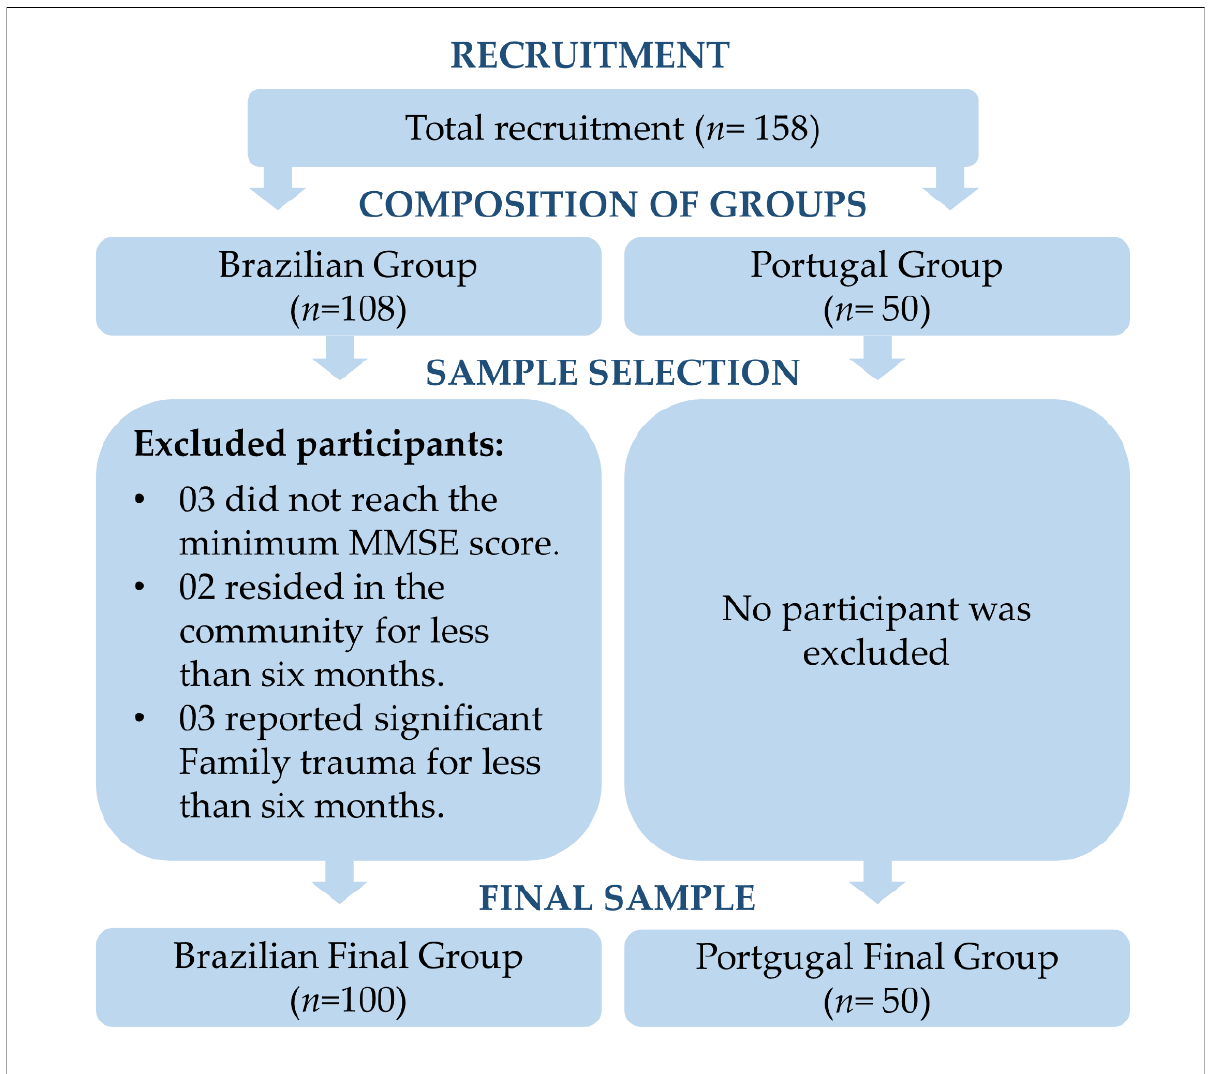
Figure 1. Flowchart of the recruitment and selection process for participants according to the exclusion criteria. Table 1. Socioeconomic characteristics between Brazil and Portugal.